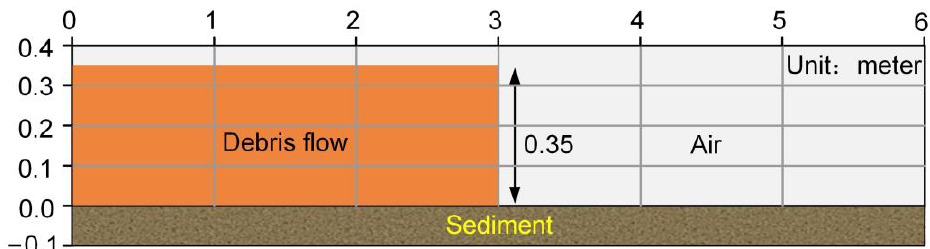
Figure 9. Schematic diagram of dam break test model size.